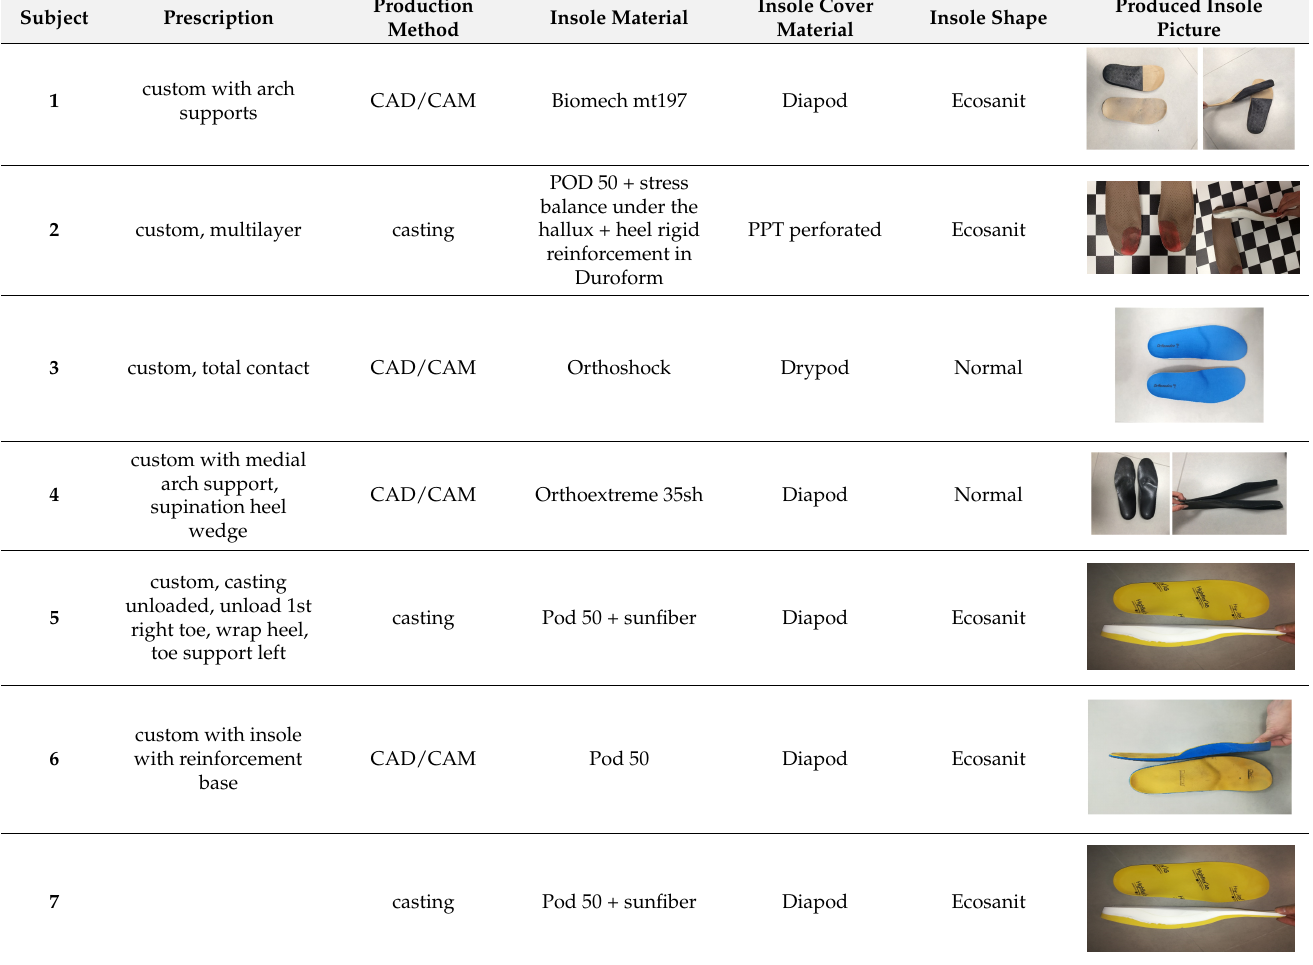
Figure 2. Details of sEMG probes location. 2.3. Custom Insoles Details of CI are reported in Table 2. Table 2. Technical details of CI.